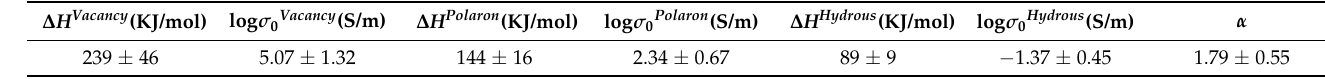
Table 3. Values of parameters contained in Equation